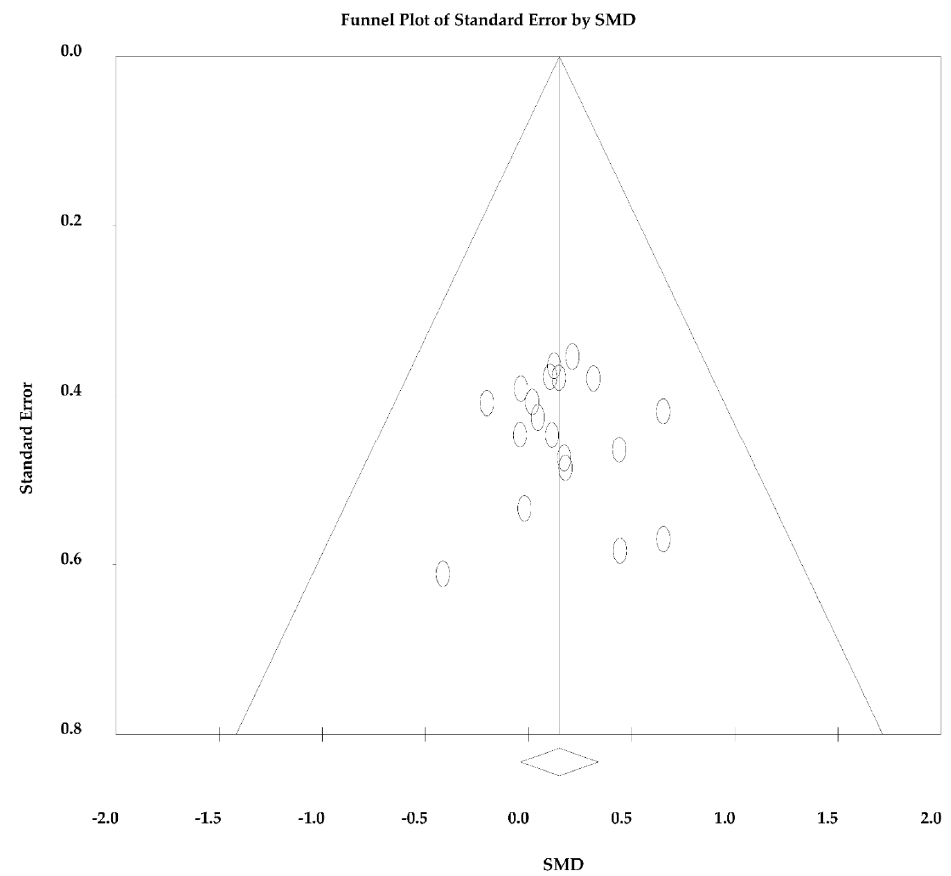
Figure 4. Funnel plot standardized mean difference (SMD) in mean vs. standard error of 𝑉(cid:4662) O 2 max/peak.